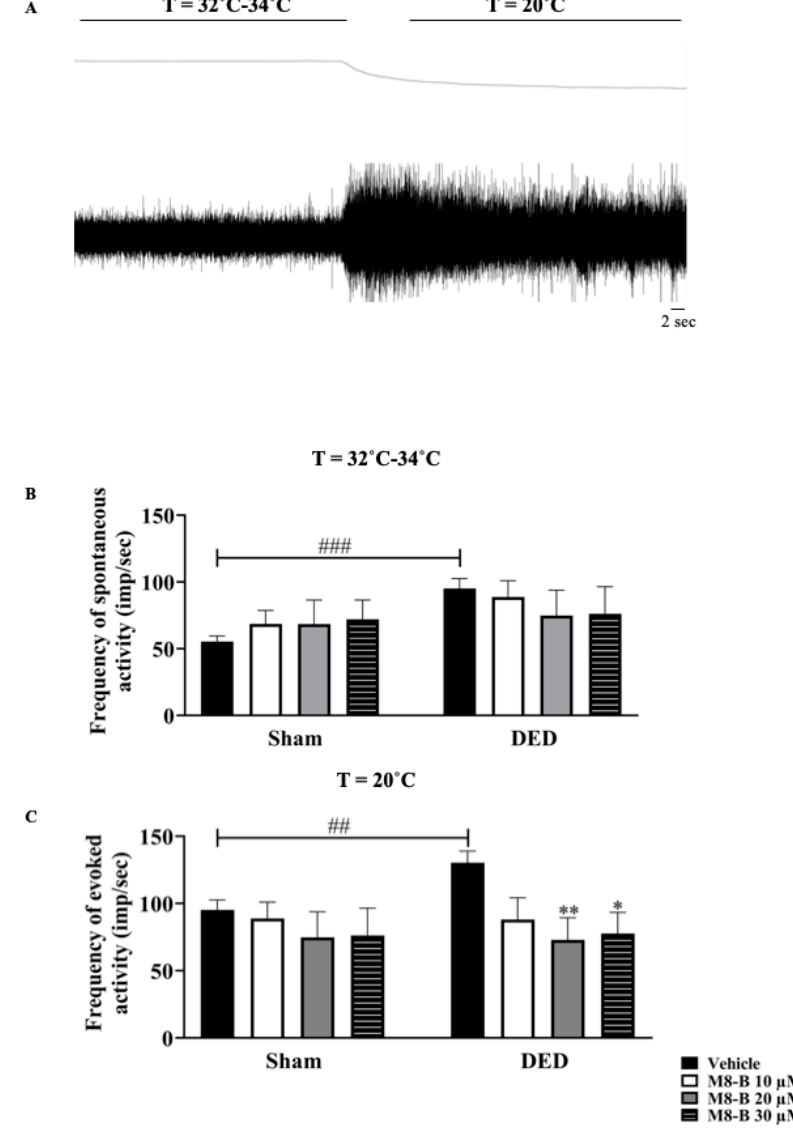
Figure 3. The acute instillation of TRPM8 antagonist M8-B in sham and DED ex vivo eye preparations. ( A ) Electrophysiological trace illustrating the extracellular spontaneous (32 ◦ C) and evoked (20 ◦ C) activity of the ciliary nerve fiber in control mice; time scale = 2 s. Histograms illustrating ( B ) the spontaneous activity of the ciliary nerve fiber after ex vivo instillation of 10, 20, and 30 µ M M8-B in sham and DED at 32 ◦ C; ( C ) the evoked activity of the ciliary nerve fiber after ex vivo instillation of 10, 20, and 30 µ M M8-B in sham and DED at 20 ◦ C at day 21. Sham and DED mice n = 5–8. * p < 0.05 and ** p < 0.01 relative to DED vehicle group at 20 ◦ C. ### p < 0.001 relative to sham vehicle group at 32 ◦ C and ## p < 0.01 relative to sham vehicle group at 20 ◦ C. Results are expressed as the mean ± SEM.